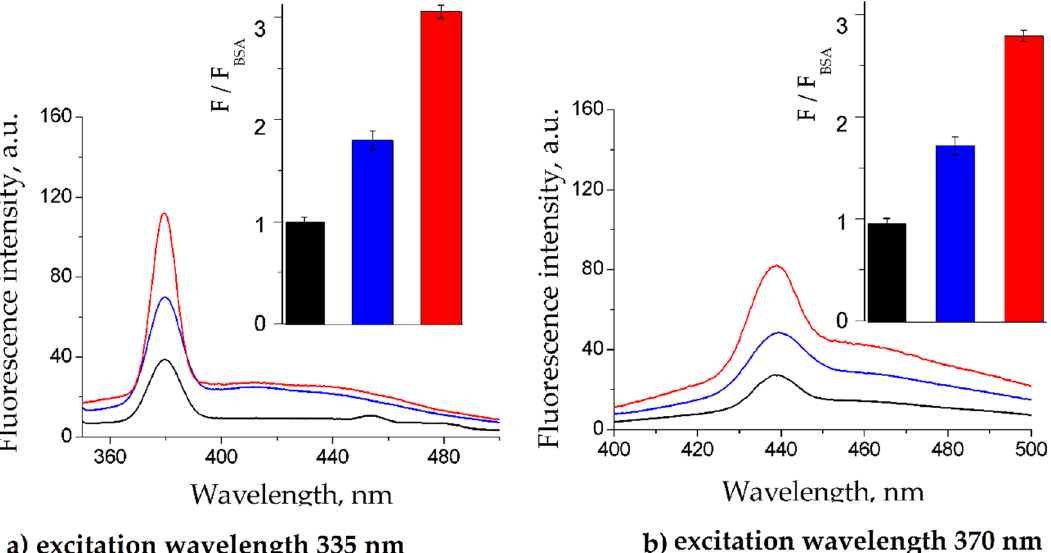
Figure 2. Emission spectra of nonglycated and differently glycated BSA at excitation wavelength 335 nm ( a ) and 370 nm ( b ). Relative increase in fluorescence intensity is shown in the inserts. Native BSA (black lines and bars), g10_BSA (blue lines and bars) and g30_BSA (red lines and bars) signify the use of 0, 10 and 30 mM glucose for glycation.